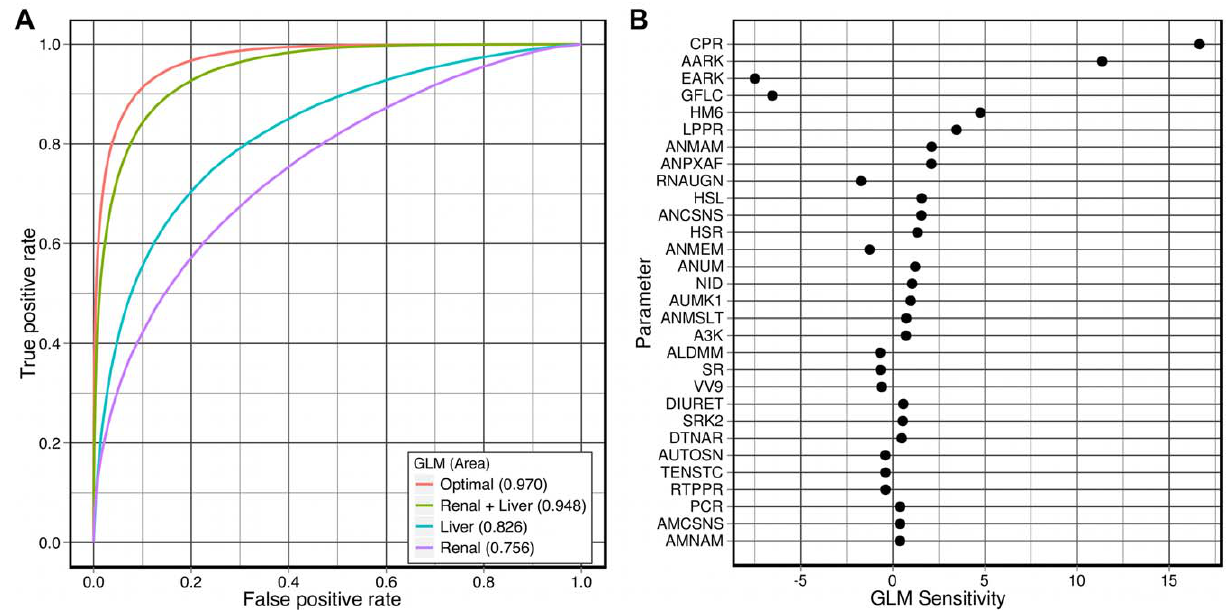
Figure 8. Evaluation of linear classifiers for identifying hypertensive virtual individuals. Each classifier (binomial GLM) was fitted to a random 1% sample of the virtual population and then evaluated on the remaining 99% . A: ROC curves for several classifiers; the optimal (30- parameter) classifier has an area under curve (AUC) of 0 : 970 , demonstrating high predictive power. The 6-parameter ‘‘Renal + Liver’’ classifier performs nearly as well (AUC=0.948). B: The parameter sensitivity of the optimal classifier. The y-axis measures the variation in the prediction over the range of values for each parameter.